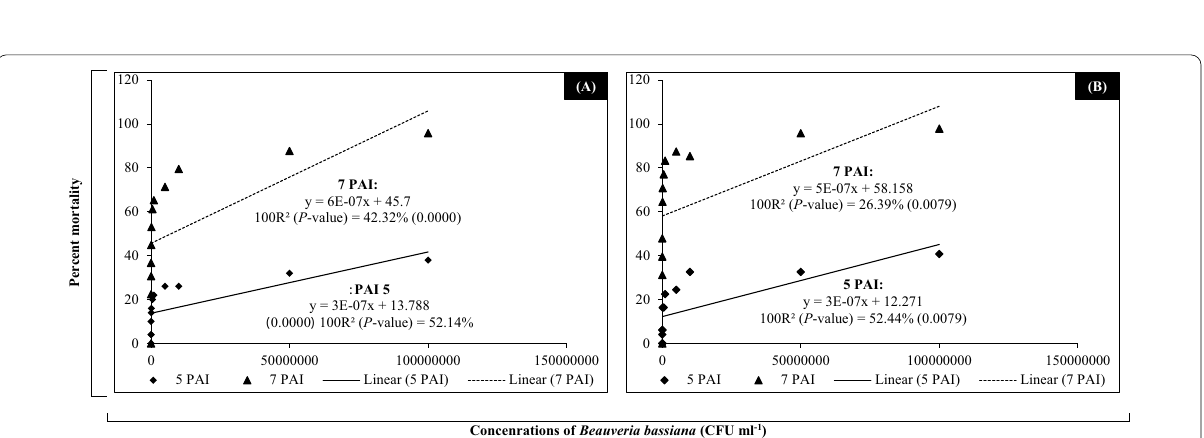
Fig. 6 Linear regression equation (Ŷ b ax), coefficient of determination (100R 2 ) and scatter diagram showing the fitted simple regression line of = ± Ŷ [percent mortality of adult male Bactrocera zonata (a) and adult female Bactrocera zonata (b) ] on X [Concentrations of Beauveria bassiana ] at different days post-application intervals